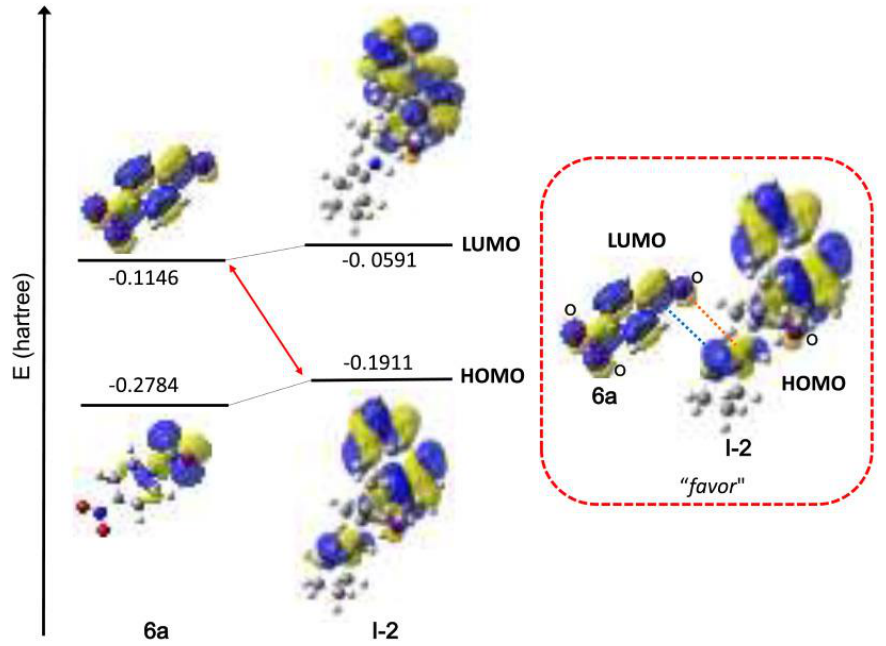
Figure 4. Frontier orbitals of 8 ( 6a in the figure represents 8 in our scheme) and I-2 obtained by DFT calculations at the B3LYP/6-31G(d) level. Reprinted with permission from Ref. [70]. Copyright 2018, Elsevier.